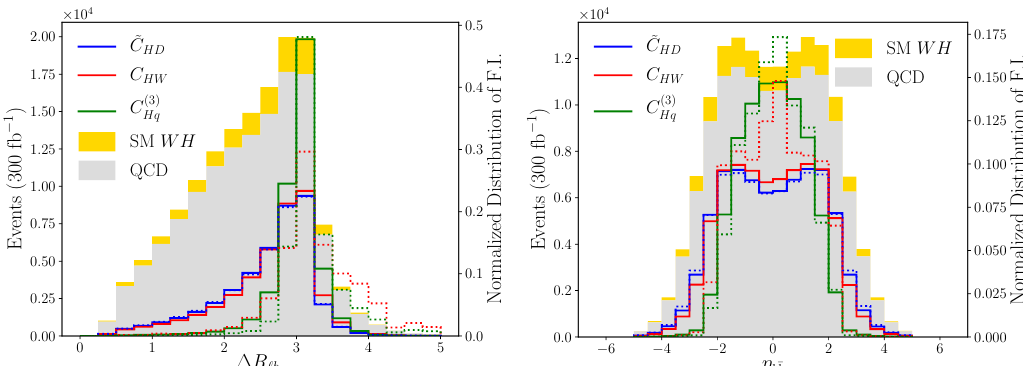
Figure 4 . Left axis: stacked histograms of the SM signal on top of the backgrounds for di(cid:11)erent kinematic observables. Right axis: normalized distributions of the diagonal elements of the Fisher information, representing the information on the three Wilson